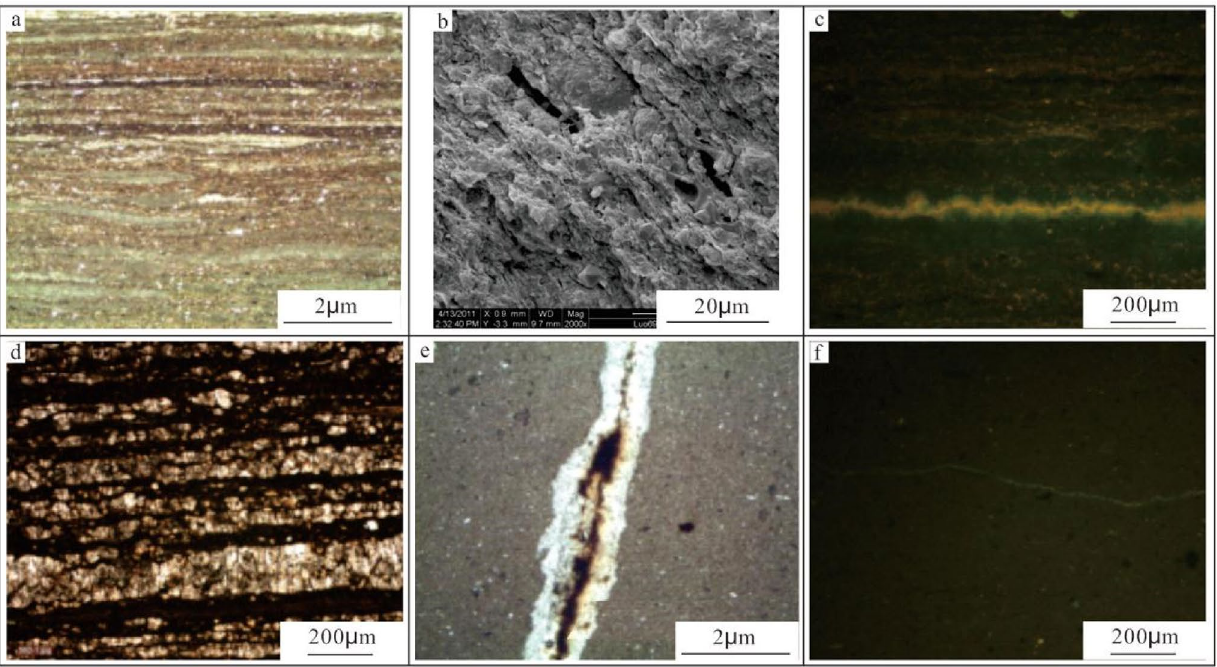
3060.62 m, the overpressure fracture is filled with bright calcite, e Well Luo 69, 3077.35 m, the calcite is half filled with high angle oblique fracture, containing oil, f Well Luo 69, 3021.05 m, calcare- ous mudstone, unfilled microfractures, green